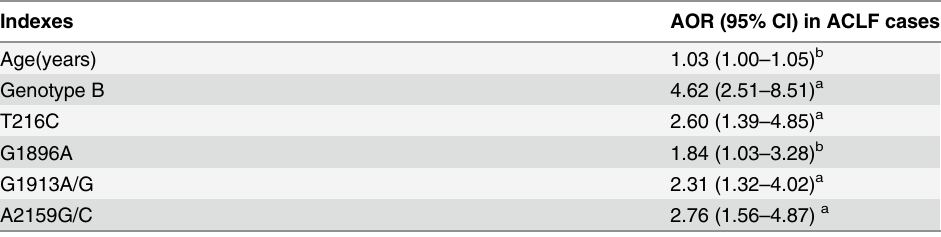
Table 6. The results of stepwise multivariate regression analysis for independent risk factors associ- ated with ACLF